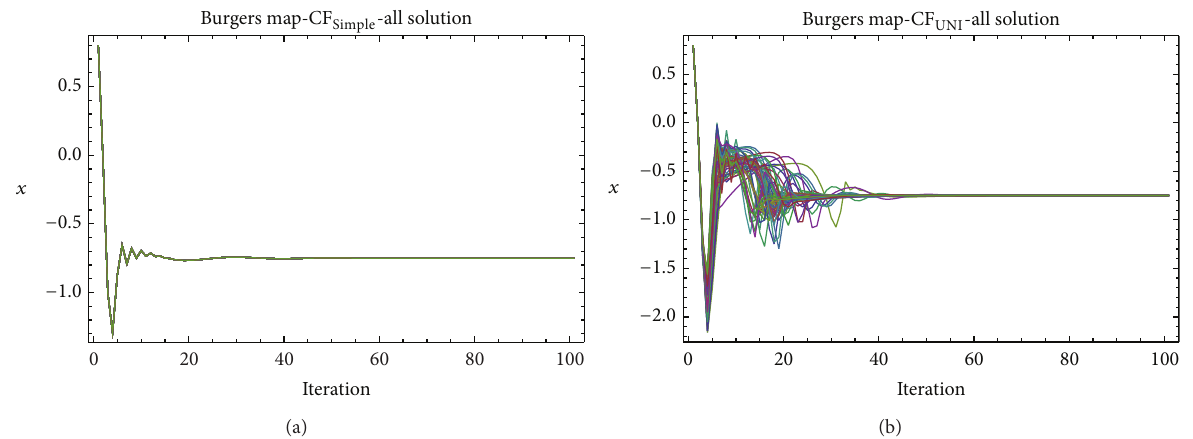
Figure 12: Simulation of all the 50 independent runs of EA, ChaosDE and Burgers map: case study 2, CF Simple (a); case study 1, CF